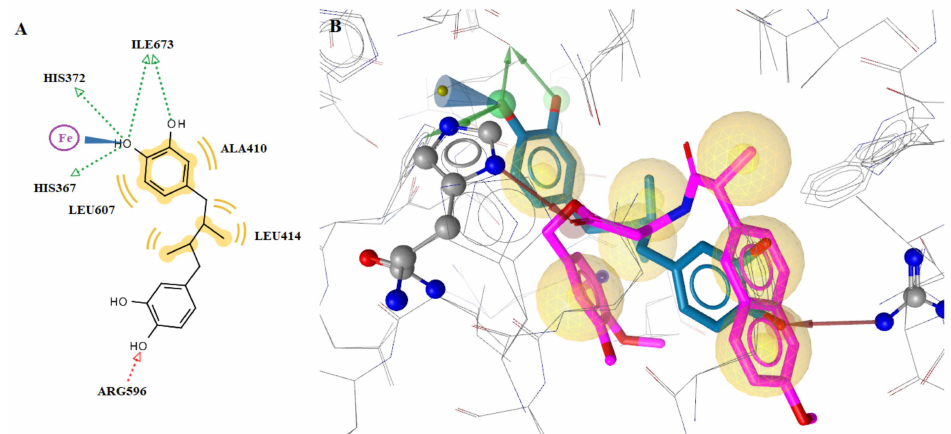
Figure 5. ( A ) 2D interaction diagram of the reference compound NDGA with the key amino acids in 5-LOX. ( B ) Superposition of compound 17 (magenta) bound to 5-LOX in comparison with NDGA (blue), with specific residues labeled. Active site zinc shown as yellow small sphere, red and green dotted arrows indicate H-bond, and yellow spheres hydrophobic interactions.